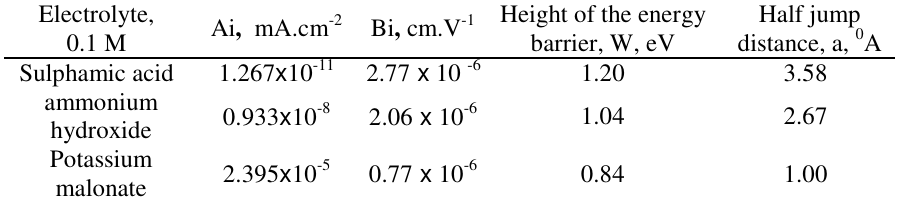
Figure 2. Variation of log ionic current density (log i Table 5. Anodization of Zr-2 in 0.1 M solutions. Estimation of kinetic parameters of high field ion conduction (Control by oxide/ Electrolyte